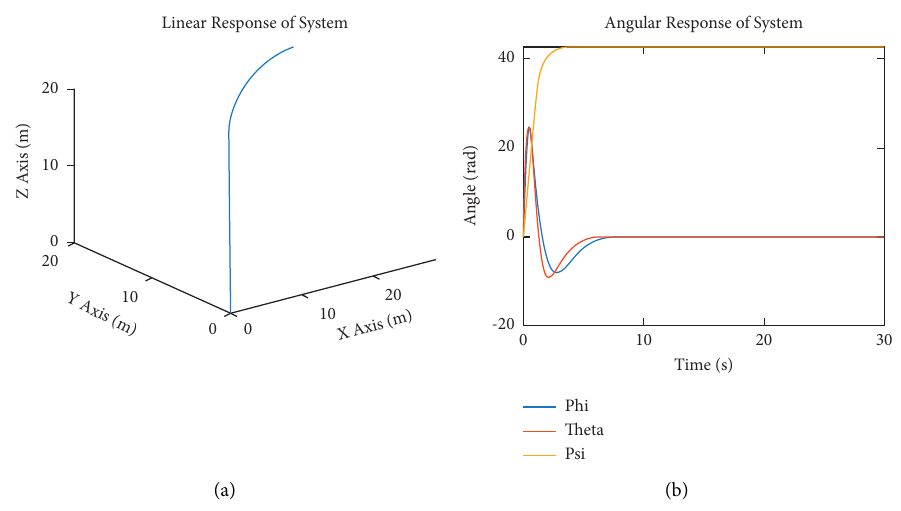
Figure 6: System response for psi at 45 ° and altitude